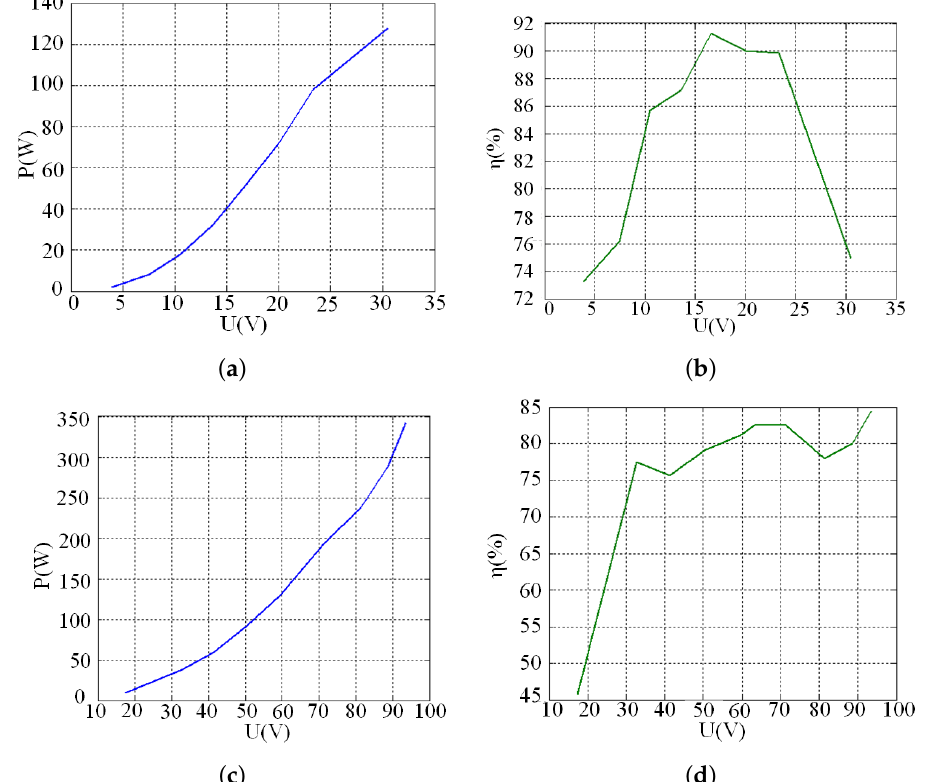
Figure 17. Varying supply voltage test system performance: ( a ) Experimental output power curve of variable power supply voltage—Load 50 Ω ; ( b ) Experimental system efficiency curve with variable power supply voltage—Load 50 Ω ; ( c ) Experimental output power curve of variable power supply voltage—Load 10.5 Ω ; ( d ) Experimental system efficiency curve with variable power supply voltage— Load 10.5 Ω